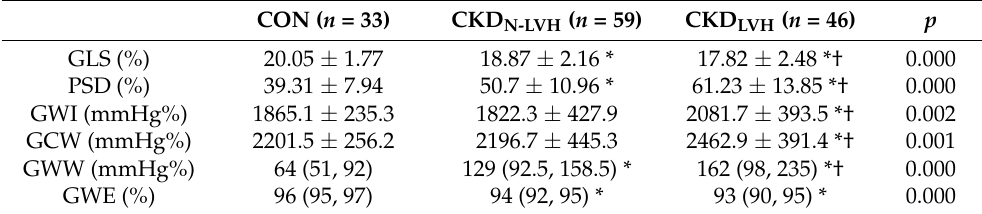
Table 3. Left ventricular global longitudinal strain and myocardial work analysis.